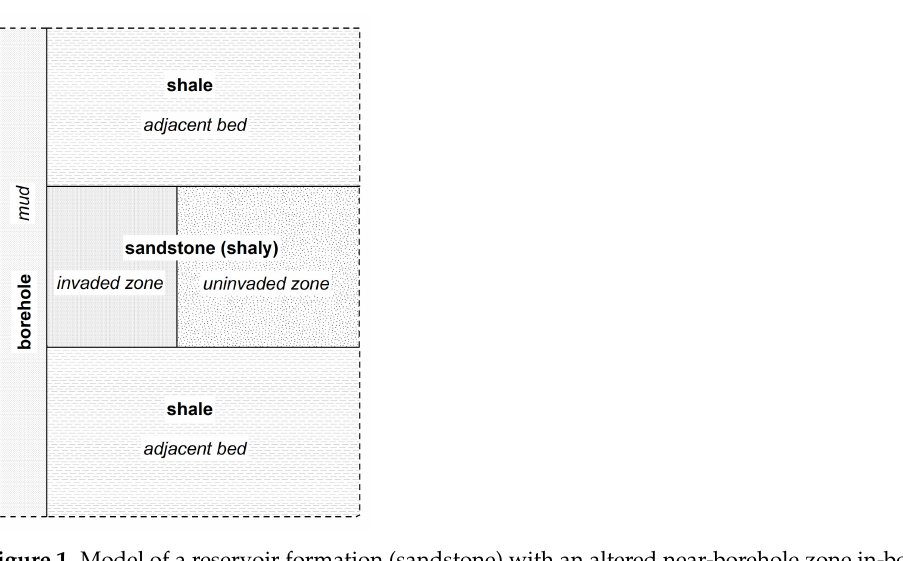
Figure 1. Model of a reservoir formation (sandstone) with an altered near-borehole zone in-between shale